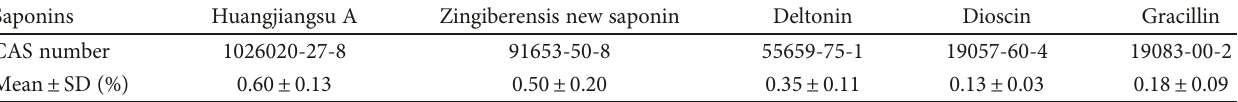
Table 1: Saponin content of fresh rhizome of Dioscorea zingiberensis C. H. Wright ( n = 21 )